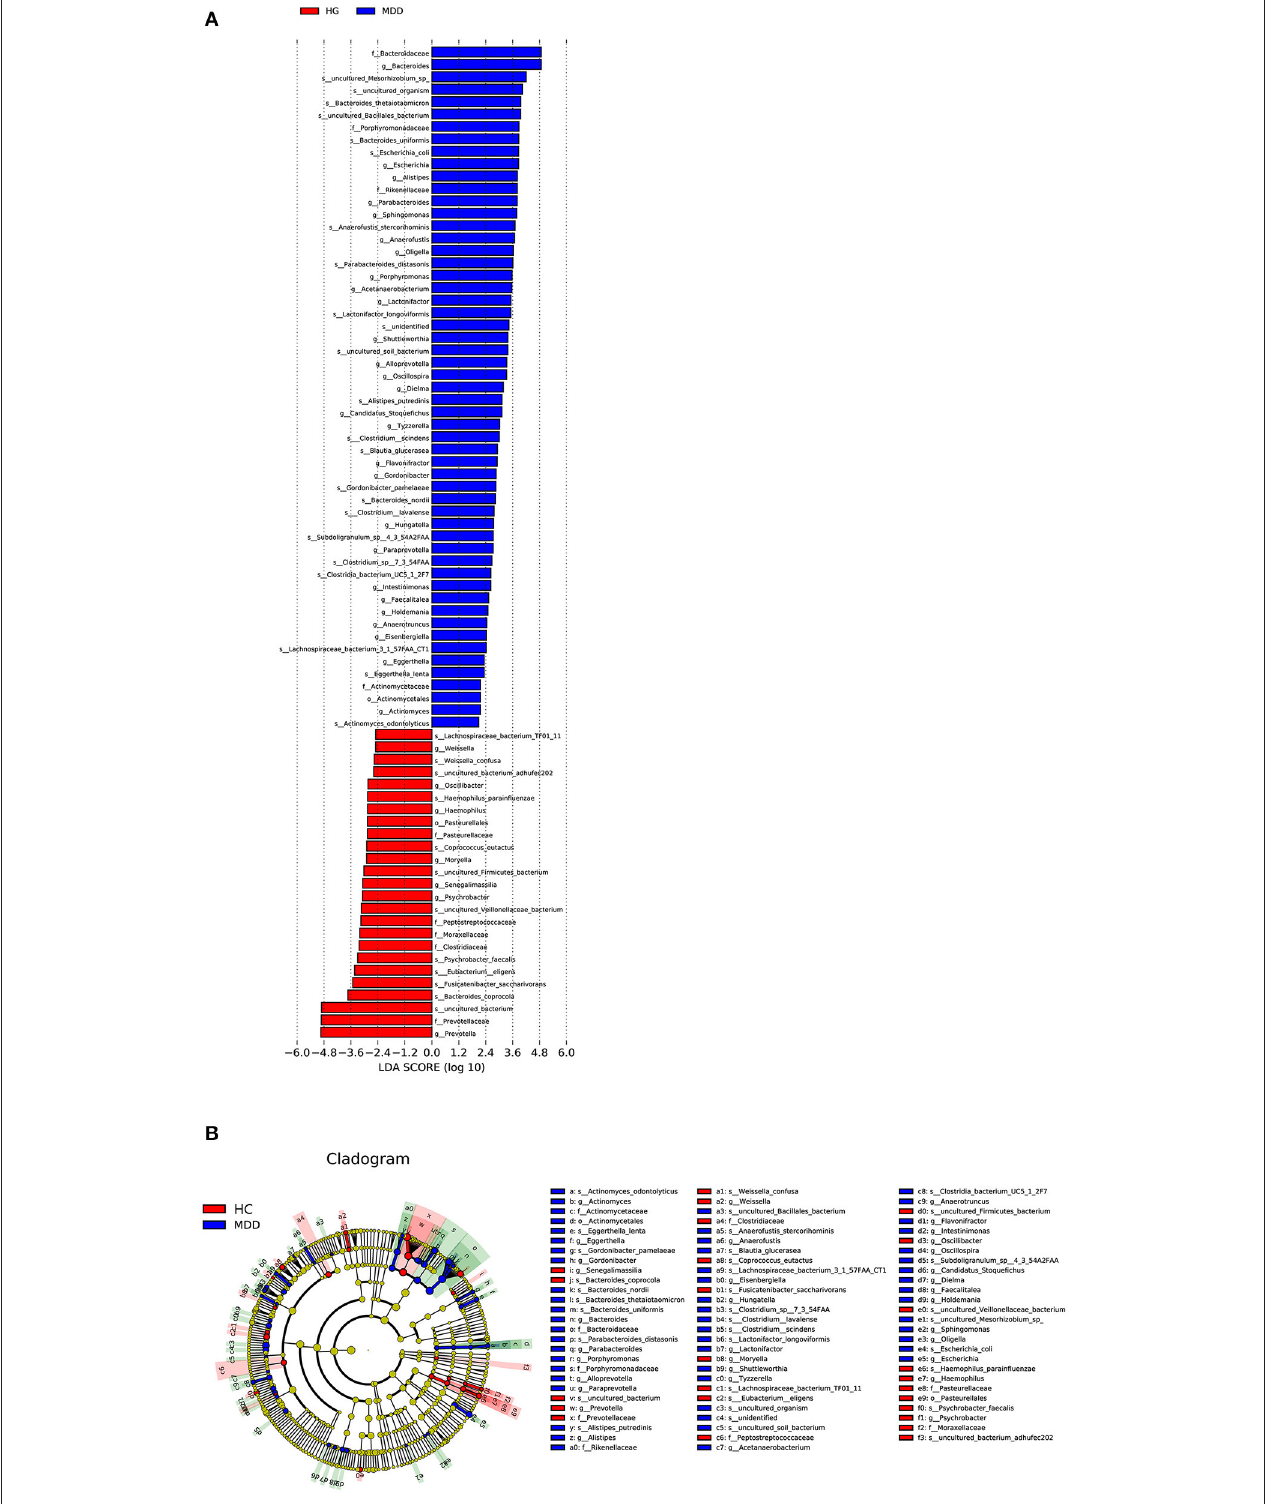
FIGURE 5 | (A) Taxonomic biomarkers found by LEfSe in HC (blue) and MDD (red). Only taxa with p < 0.05 and LDA score (log10) are shown. (B) Cladogram indicating the phylogenetic relatedness of the discriminant taxa.